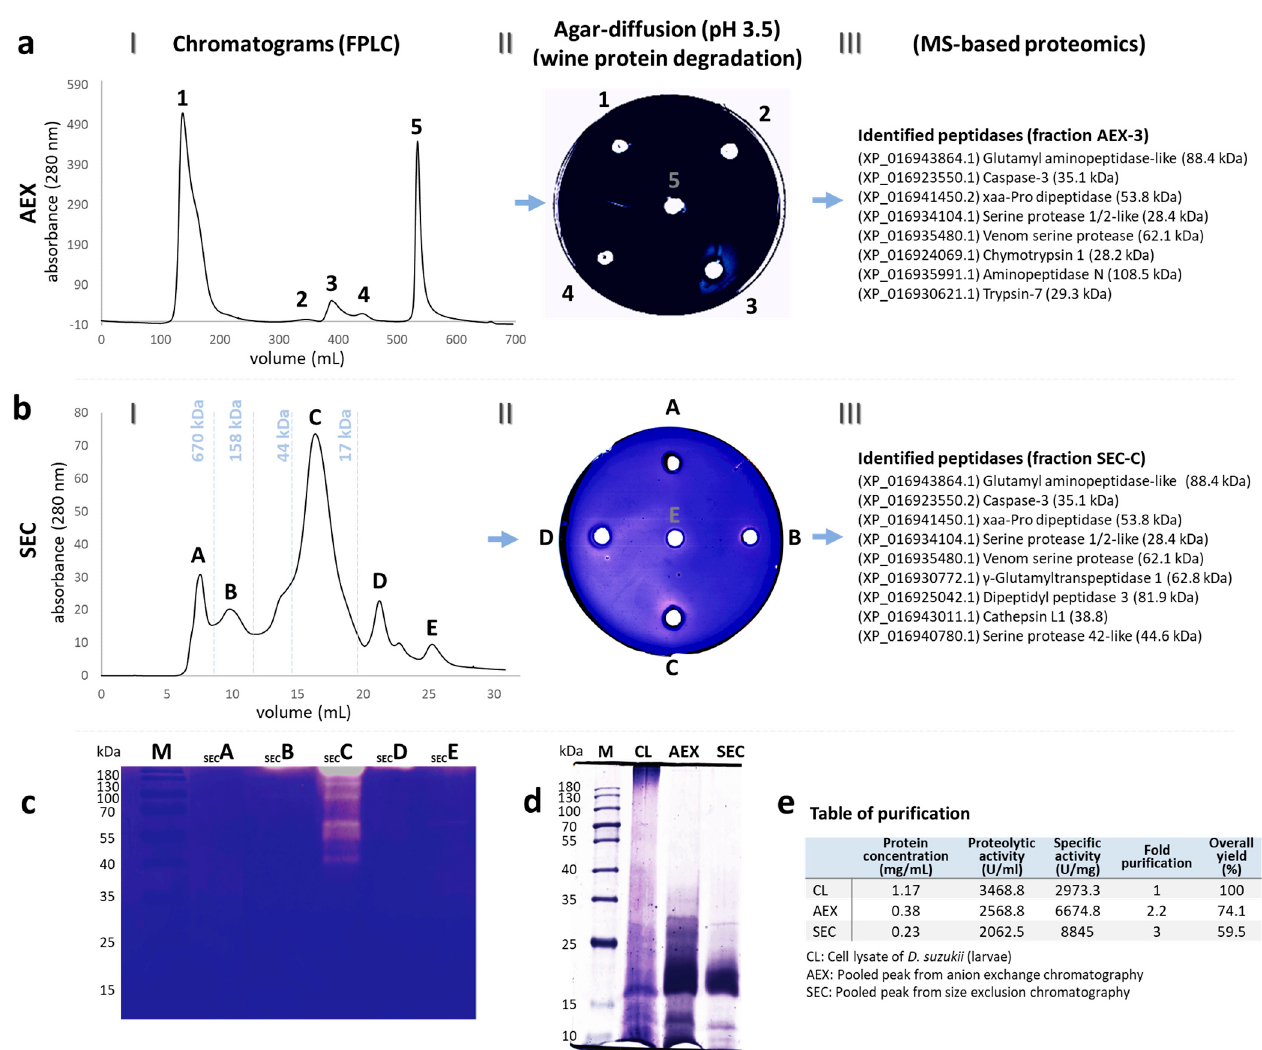
Figure 2. Partial purification of peptidases from the D. suzukii larvae. ( aI ) Anion exchange chromatography (AEX) of the cell lysates (CL) of the D. suzukii larvae. ( aII ) The proteolytic activity of each peak ( aIII ) Peptidases in peak III identified by MS-based proteomics. ( bI ) Size exclusion chromatography (SEC) of peak 3 from the AEX step. ( bII ) Degradation of wine proteins assessed by the agar diffusion assay. ( bIII ) Peptidases in peak C identified by MS-based proteomics. ( c ) Protein peaks purified